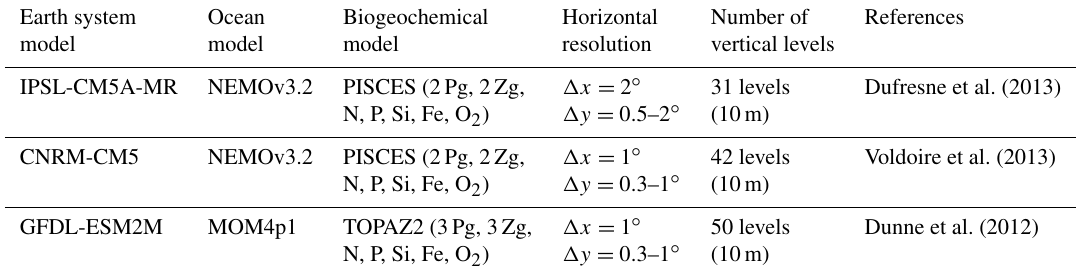
Table 2. Characteristics of the ESMs selected for the regional downscaling. The values in parentheses indicate the thickness (in meters) of the surface layer in the ESM ocean model. Pg and Zg abbreviate “phytoplankton group” and “zooplankton group”,